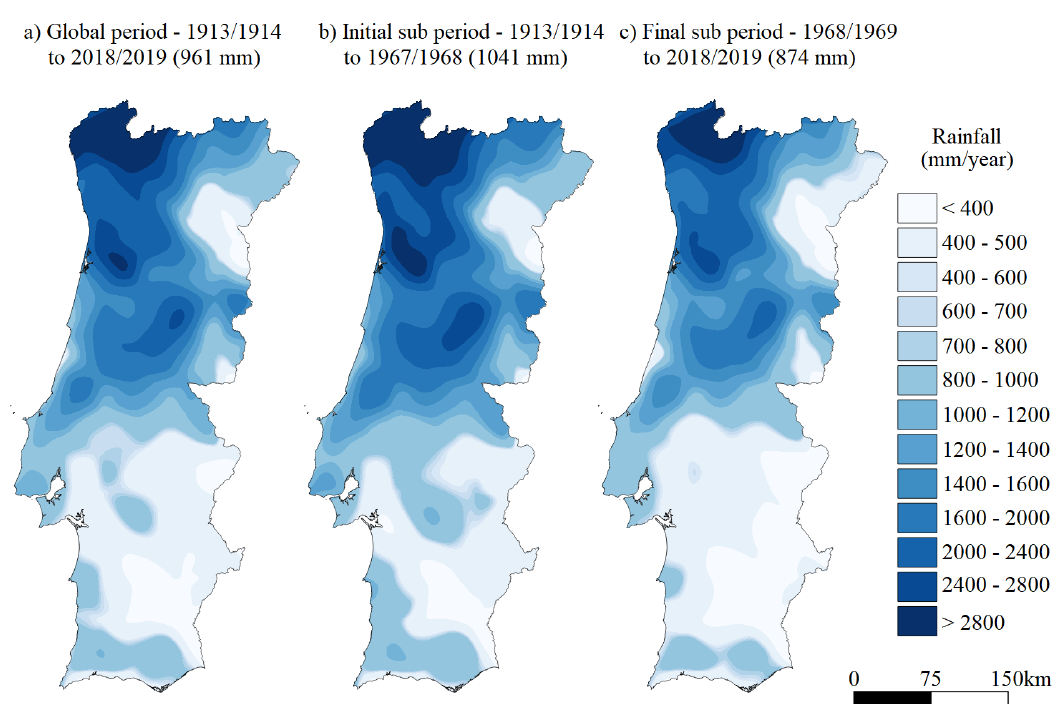
Figure 5. Mean annual rainfall maps for the global period (106 hydrological years) and for the initial (55 hydrological years) and final (51 hydrological years) sub-periods based on the 532 rain gauges schematically located in Figure 1 (between brackets, the weighted mean annual rainfall in each period given by the cubic spline